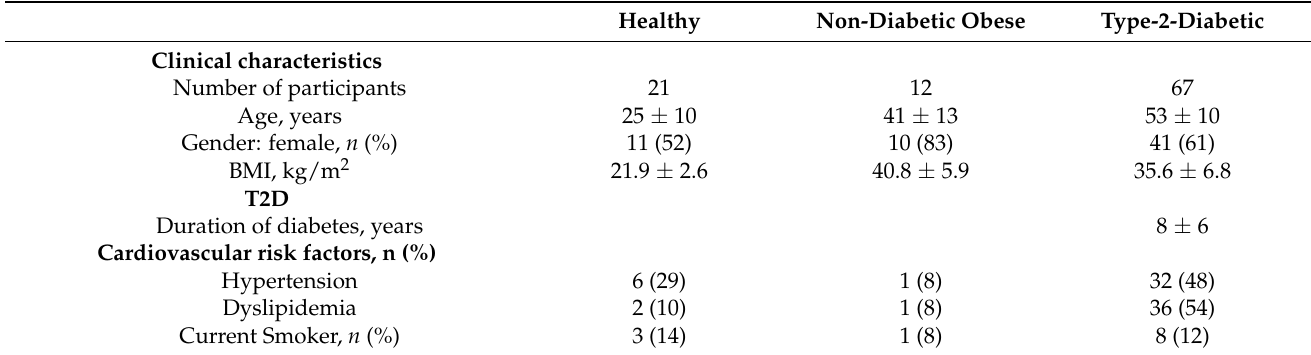
Table 1. Study population clinical characteristics. Healthy Non-Diabetic Obese